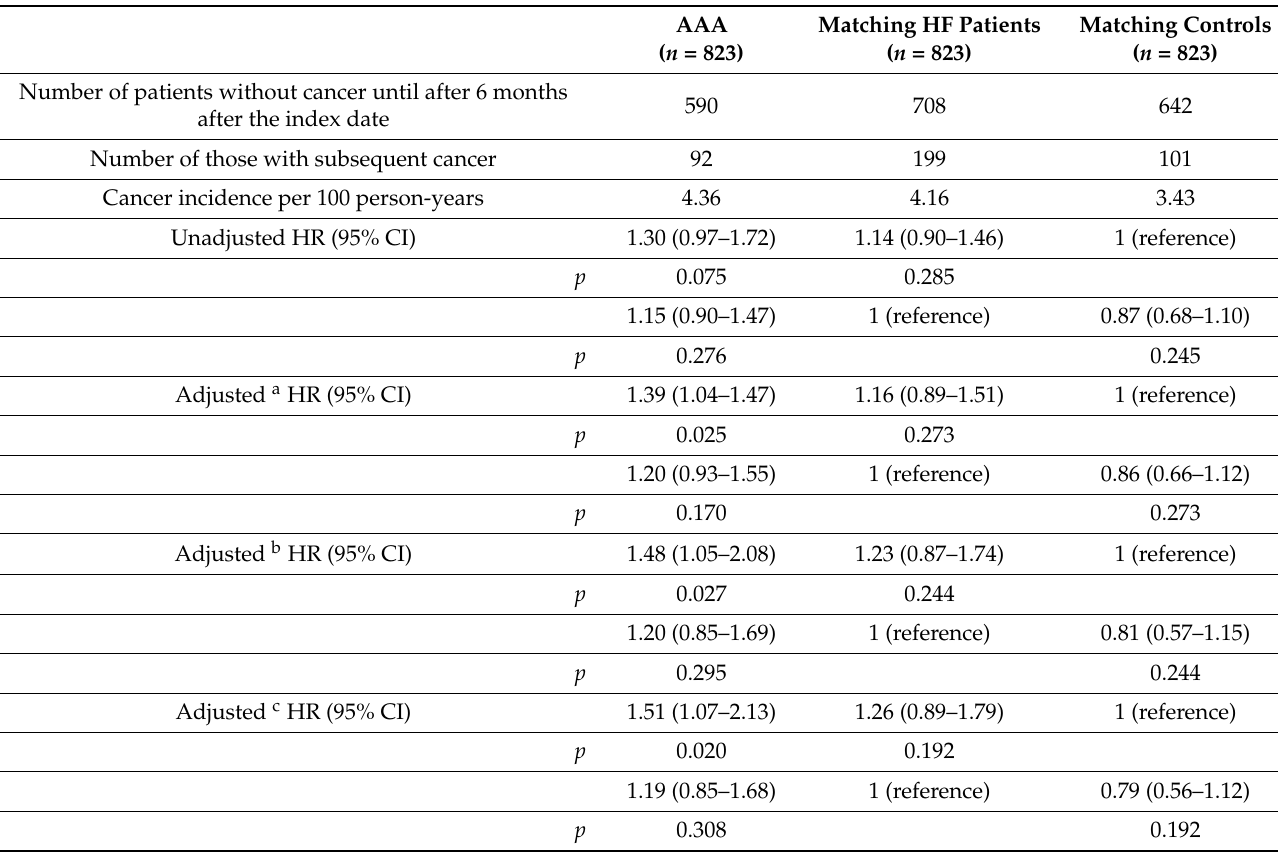
Table 4. Cancer incidence in the subjects without cancer until after 6 months after the index date.